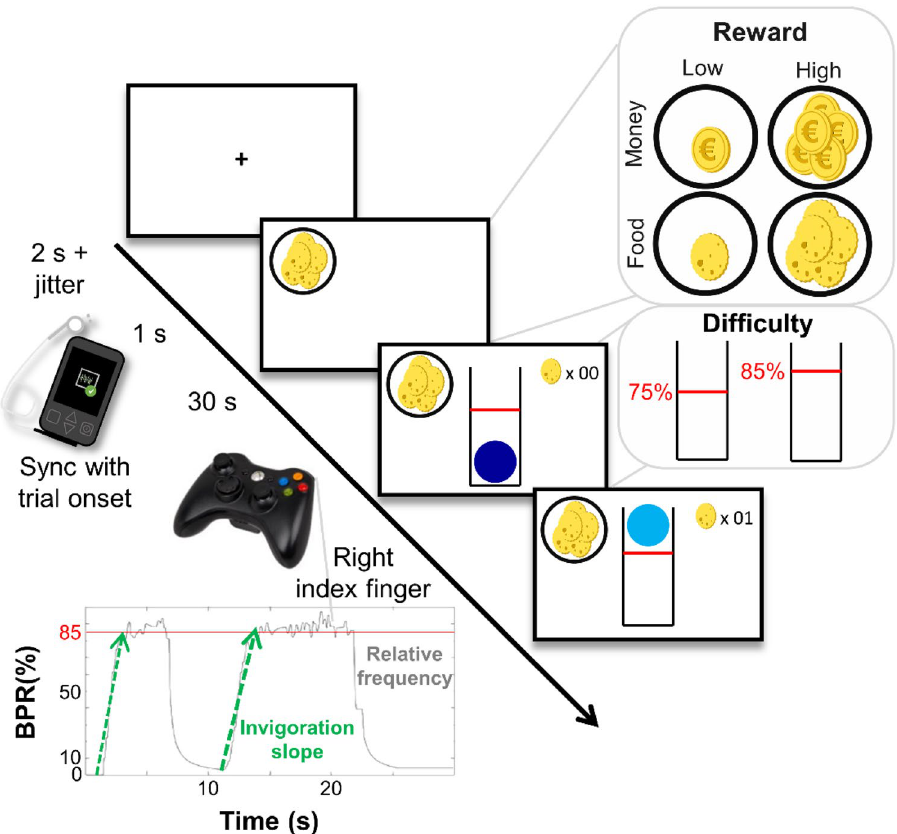
Figure 3. Schematic depiction of the effort allocation task. First, fixation cross is shown, followed by the reward cue. To earn reward, participants have to keep a ball above the red line by repeatedly pressing a button with their right index finger. Reward magnitude (low vs. high), difficulty (easy vs. hard), and reward type (food vs. money) were manipulated as task conditions. The lower left graph shows a representative time series of a high- difficulty trial, depicting effort output as button press rate, BPR, in % relative to the maximum frequency of the participant. Invigoration slopes captured how quickly participants reach effortful behavior during a trial to collect the reward. Effort maintenance relates to the average relative frequency on the trial. Figure taken from 14 under CC BY license (https:// creat iveco mmons. org/ licen ses/ by/4. 0/); no changes have been made to the